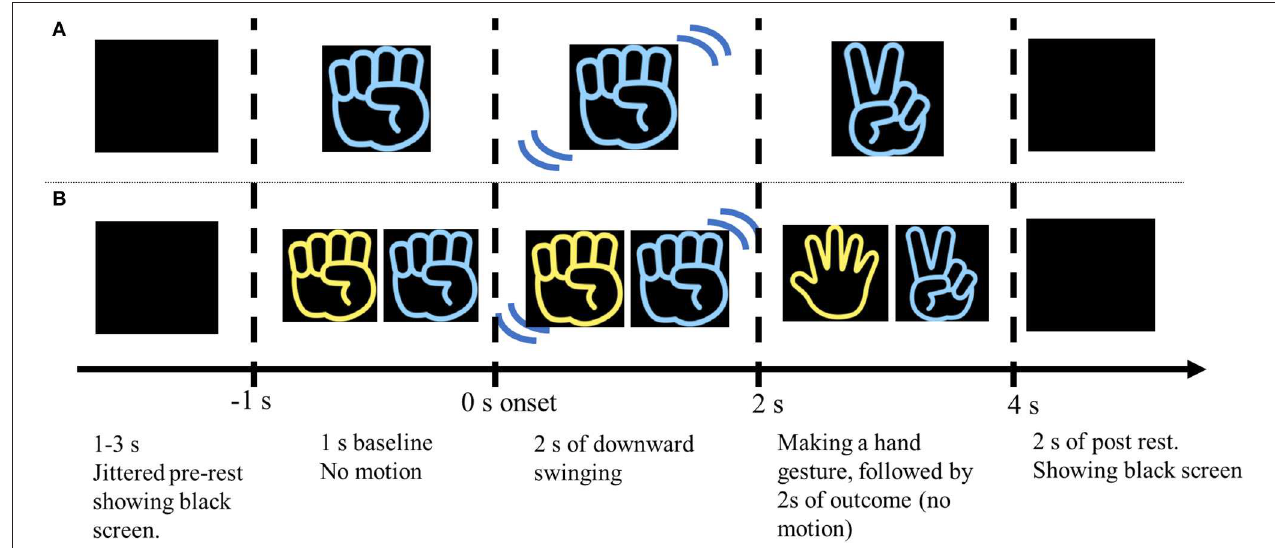
FIGURE 1 | Schematic illustration of the experimental procedure in the AO and CH sessions. (A) The participants watched a 5-s movie clip of a RPS game performed by one (blue or yellow) right hand. The outcome gesture was apparent 2s after the hand started moving. After the hand made a specific gesture, it remained motionless for 2s, and then disappeared. The movie clip was followed by a 2s black screen (post-rest period). Then the pre-rest period (jittered 1–3s) began, which consisted of a black screen shown prior to the next movie clip. (B) The participants were instructed to consciously support or “cheer” for a specific colored hand (blue or yellow). The hand that the participant was instructed to “cheer” for always appeared on the right side of the screen. Winning and losing trials were presented in random order.